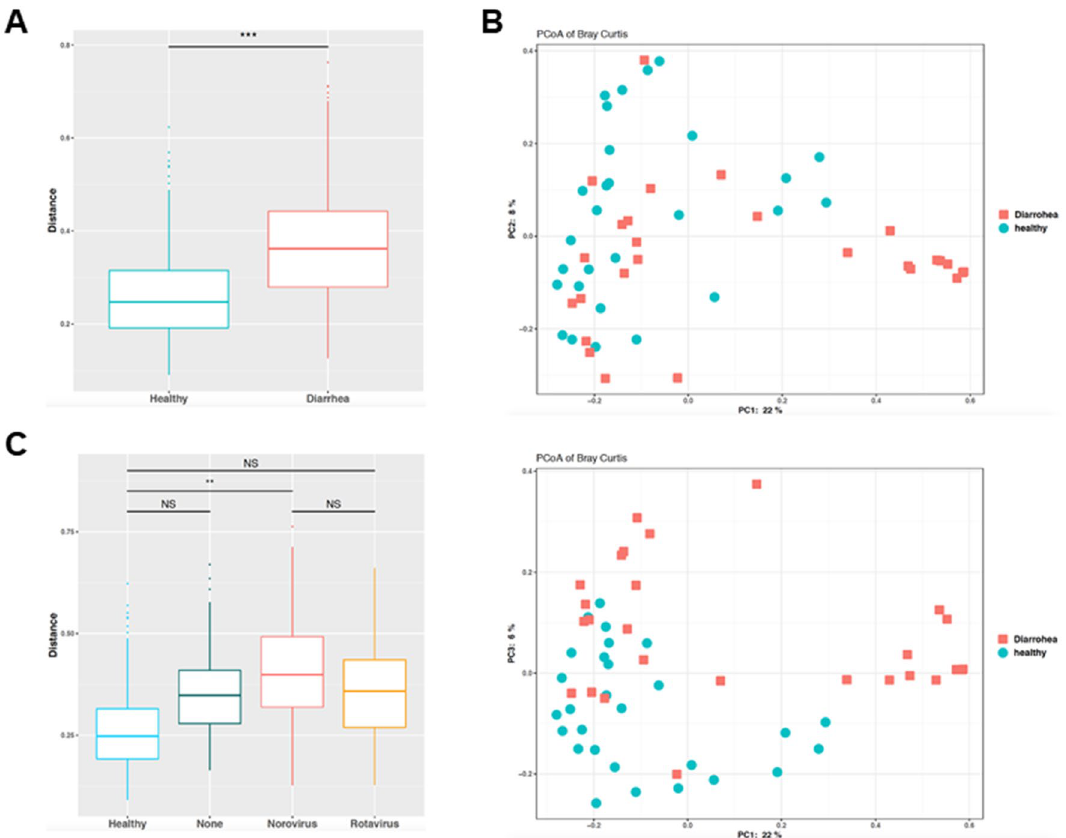
Figure 1. Beta diversities in fecal microbiome in adult patients with diarrhea and healthy adult cohorts. ( A ) Weighted Unifrac distances of fecal microbiome in individuals with diarrhea and healthy adult cohorts. Weighted unifrac distances to healthy controls indicates that individuals with diarrhea possess significantly distant fecal microbiome composition (PERMANOVA, q = 0.002). ( B ) Principal coordinate analysis (PCoA) plots based on Bray–Curtis diversity metric. ( C ) Comparing weighted Unifrac distances of fecal microbiome among individuals with diarrhea including viral none-detectable diarrhea (None), norovirus detected diarrhea (Norovirus), and rotavirus detected diarrhea (Rotavirus), to healthy controls. Fecal microbiome composition of individuals with Norovirus infection are significantly distant from healthy controls (PERMANOVA, q = 0.01). **, *** indicate PERMANOVA significant differences with q = < 0.01, and < 0.005 healthy control and viral-negative diarrhea, were not significant, respectively (q = 0.05, q = 0.087). No statistical difference in the bacterial composition was found between norovirus-positive and rotavirus-positive diarrhea (q = 0.88, Fig. 1C).